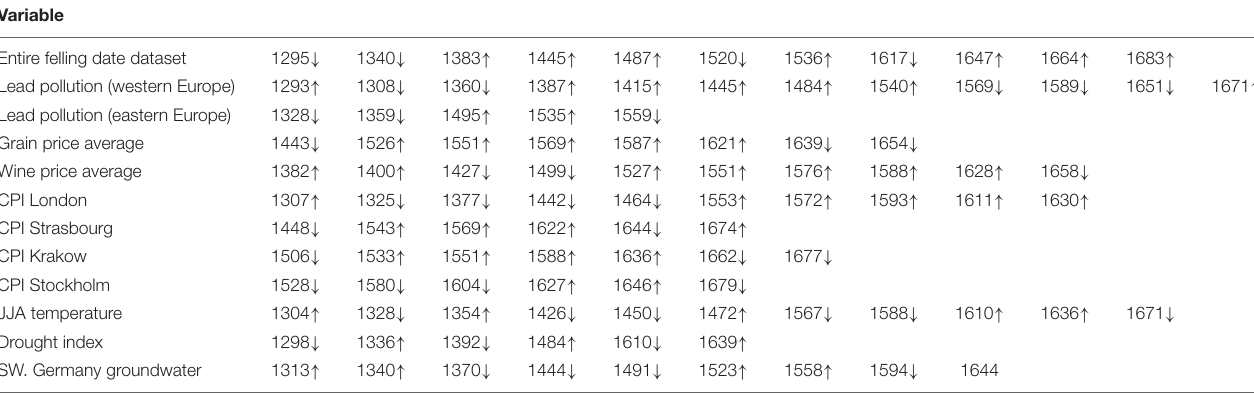
TABLE 7 | List of significant regime shifts in the in 300-year filtered and standardized subsets for comparison with the regime shifts in the felling date dataset.